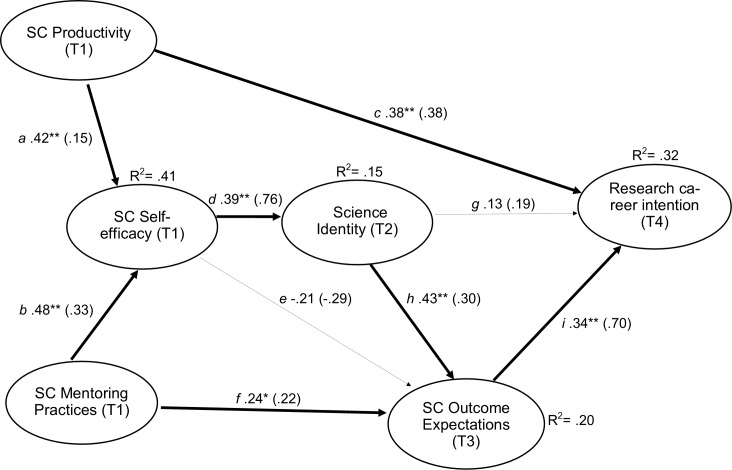
Structural model.The SC model fit the data well, and most hypothesized paths were statistically significant. * and ** represent p < .05 and p< .01, respectively. Values represent standardized (unstandardized) coefficients.